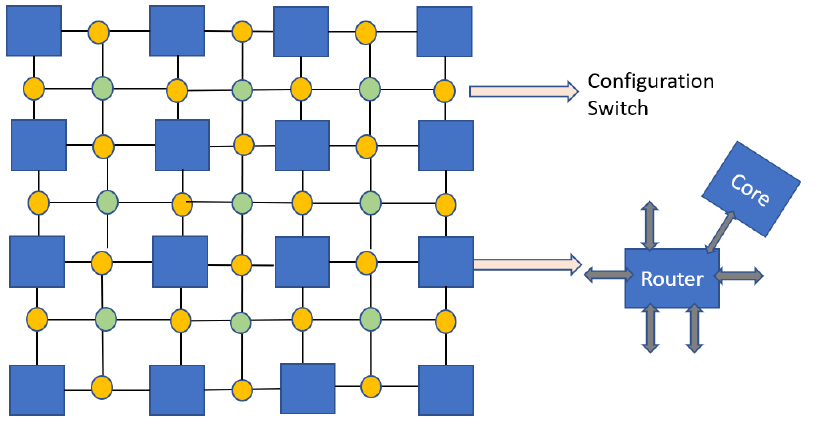
Figure 9. Arrangement of a reconfigurable NoC [7].